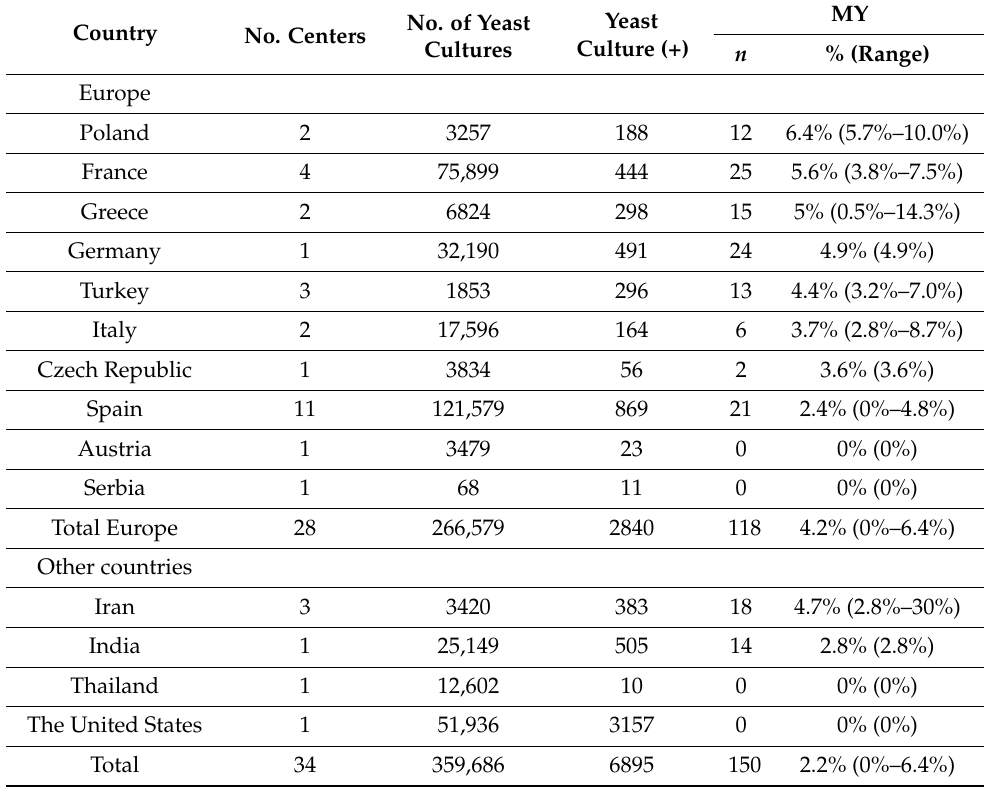
Table 1. Number of centers and mixed yeast (MY) proportions per country.